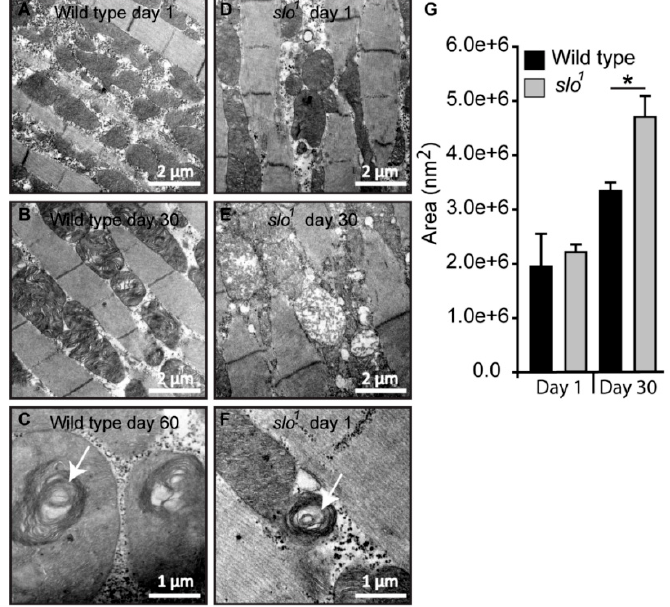
Figure 4. Mitochondrial structural defects in slo 1 mutants. ( A ) Wt mitochondria from indirect flight muscles at age 1 day show normal cristae organization. The slo 1 mutant mitochondria also show normal structure but there are increased numbers of vacuoles in the muscles ( D ). ( B ) Wt mitochondria at the age of day 30 also show a normal cristae organization. However, the slo 1 mutant mitochondria show disorganized cristae and swollen mitochondria ( E ). ( C ) Mitochondria of very old flies (at day 60) in wt show swirling of cristae, a phenotype characteristic of old age but occasionally young (day 1) slo 1 flies also show such swirls ( F ), indicated by white arrows. ( G ) The Average area indicated by histogram showed no difference in day 1 mitochondria in between wt (black) and slo 1 (gray) but significant (* p < 0.05) difference at day 30.